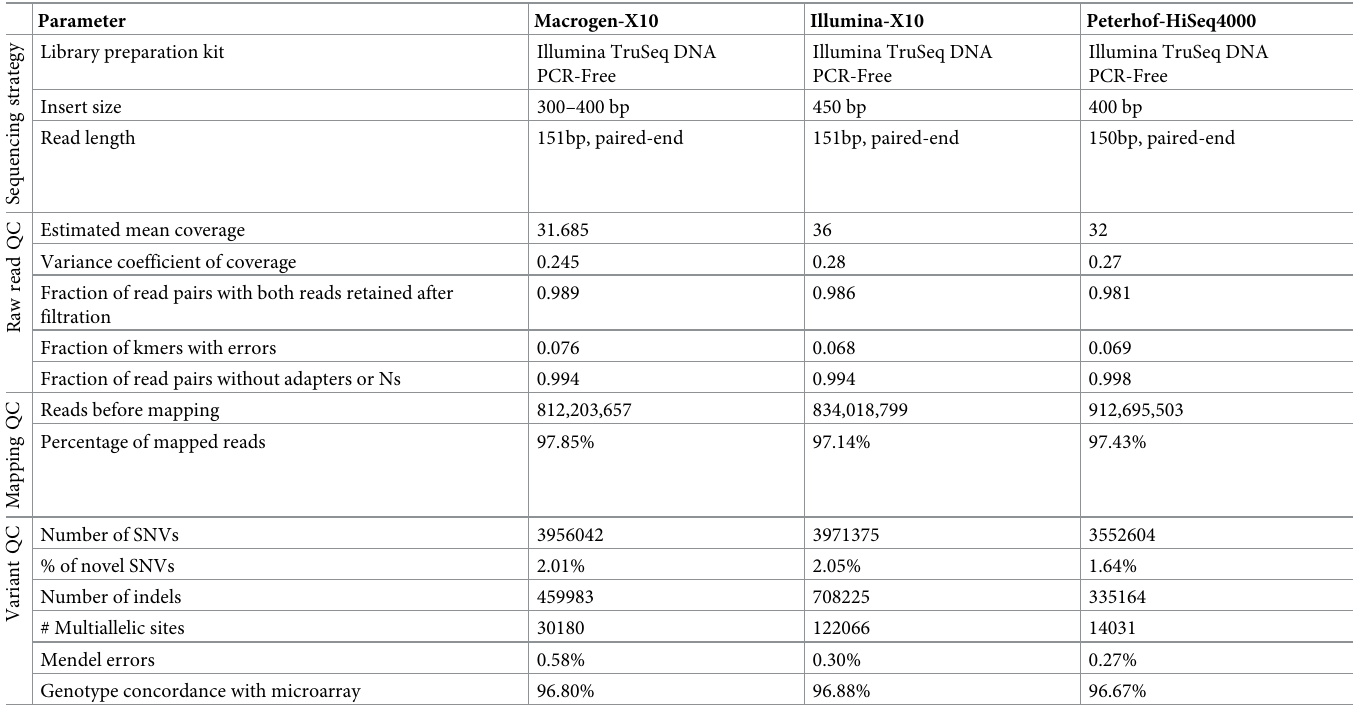
Table 2. Comparison of sequencing results (N = 17